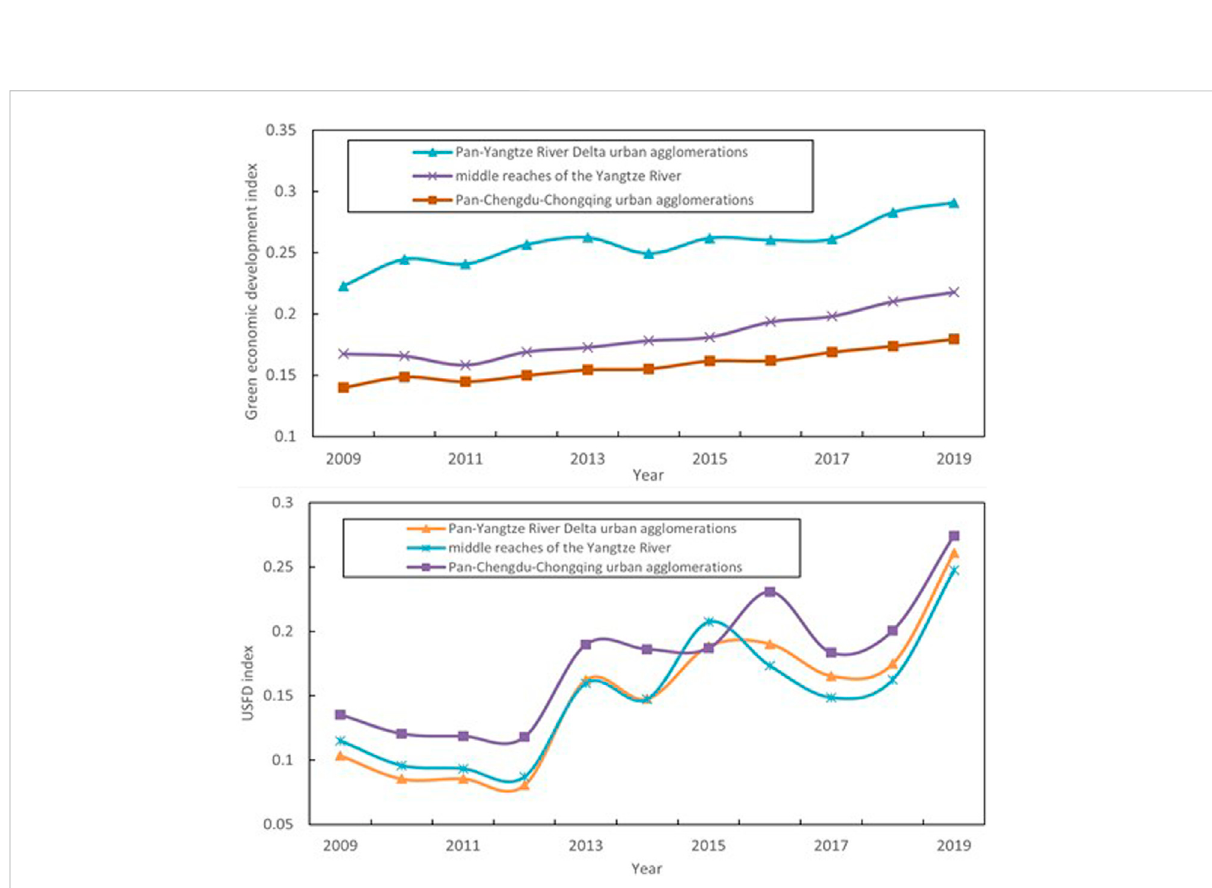
FIGURE 3 The level of USFD and green economic development in the three urban agglomerations in the YREB from 2009 to